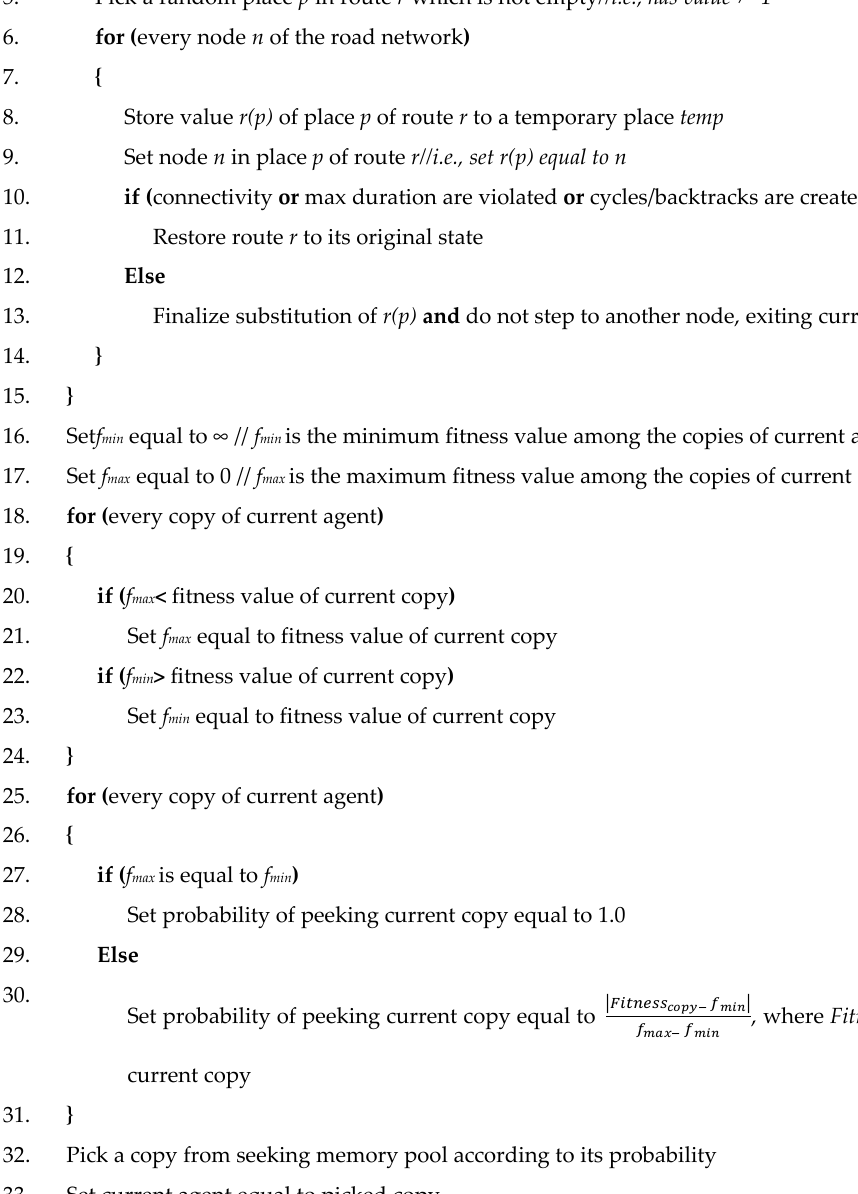
Figure 4. Pseudocode of the seeking mode process.